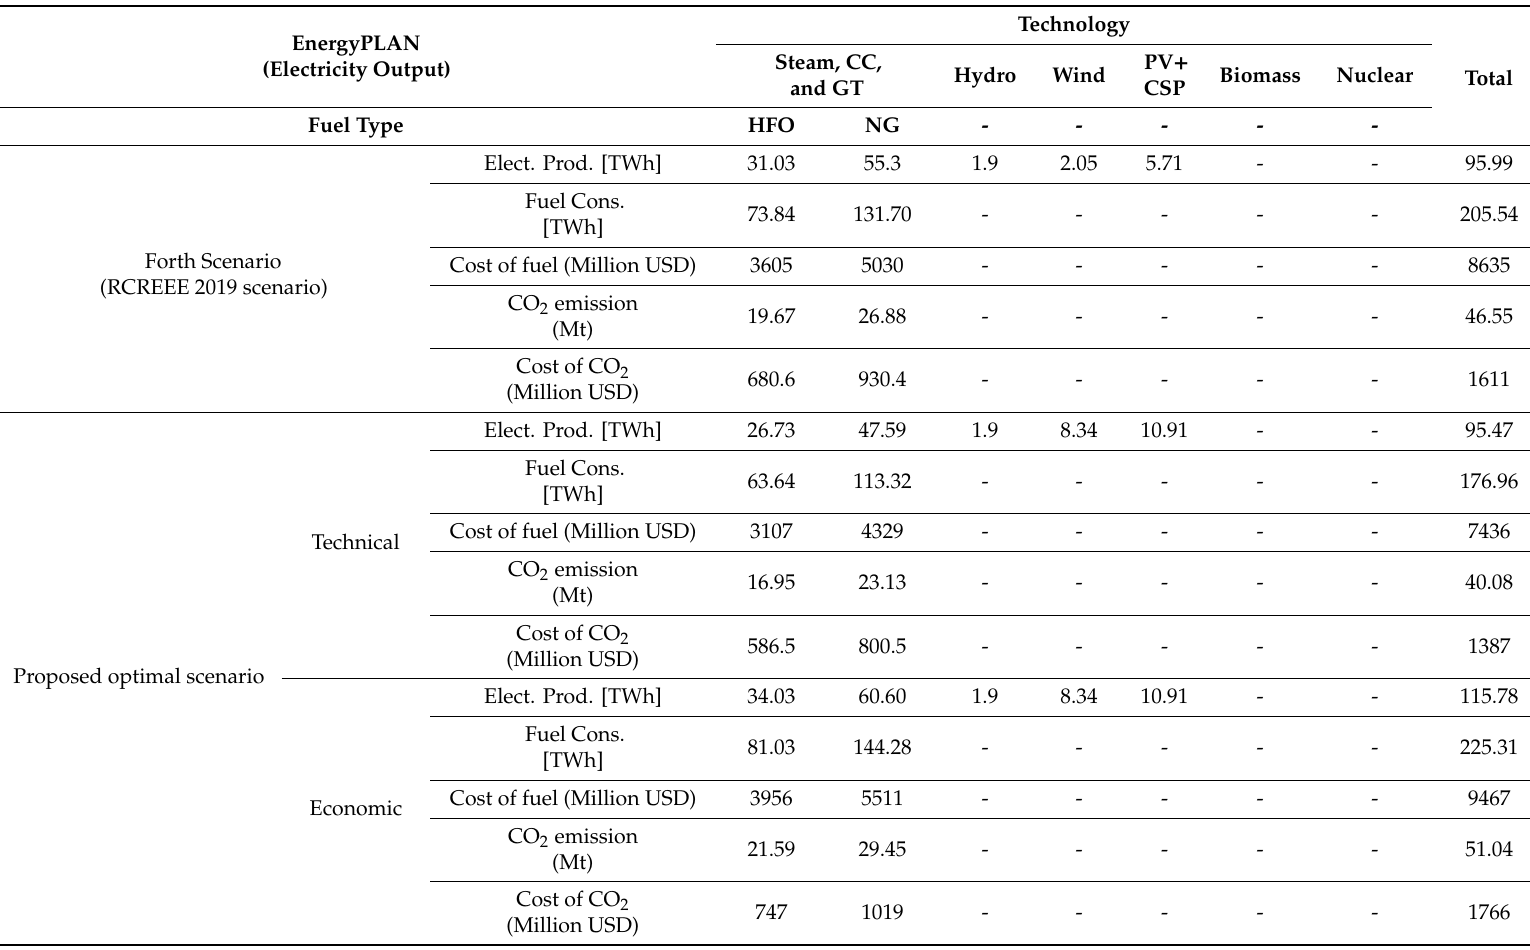
Table 16. Electricity production, fuel consumption, cost of fuel, CO 2 emission, and cost of CO 2 for the RCREEE 2019 and proposed